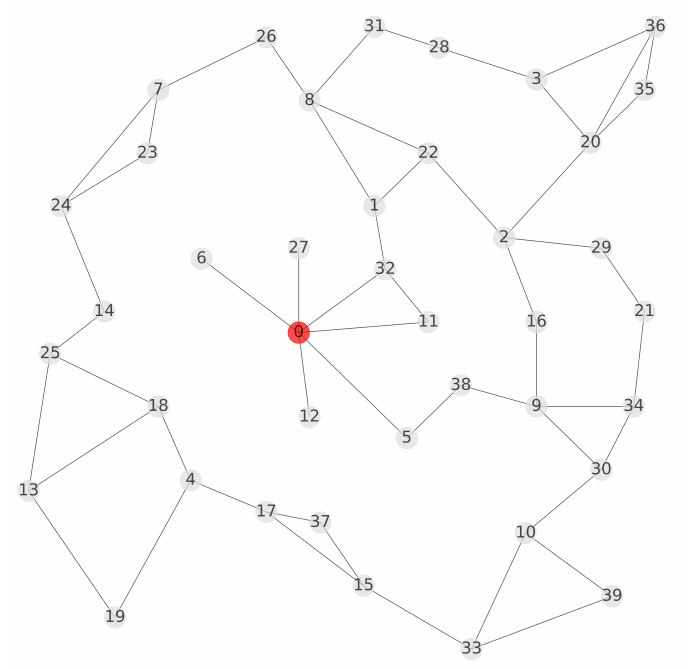
Figure 2. An optimal solution of the LP relaxation of CVRP (the depot is